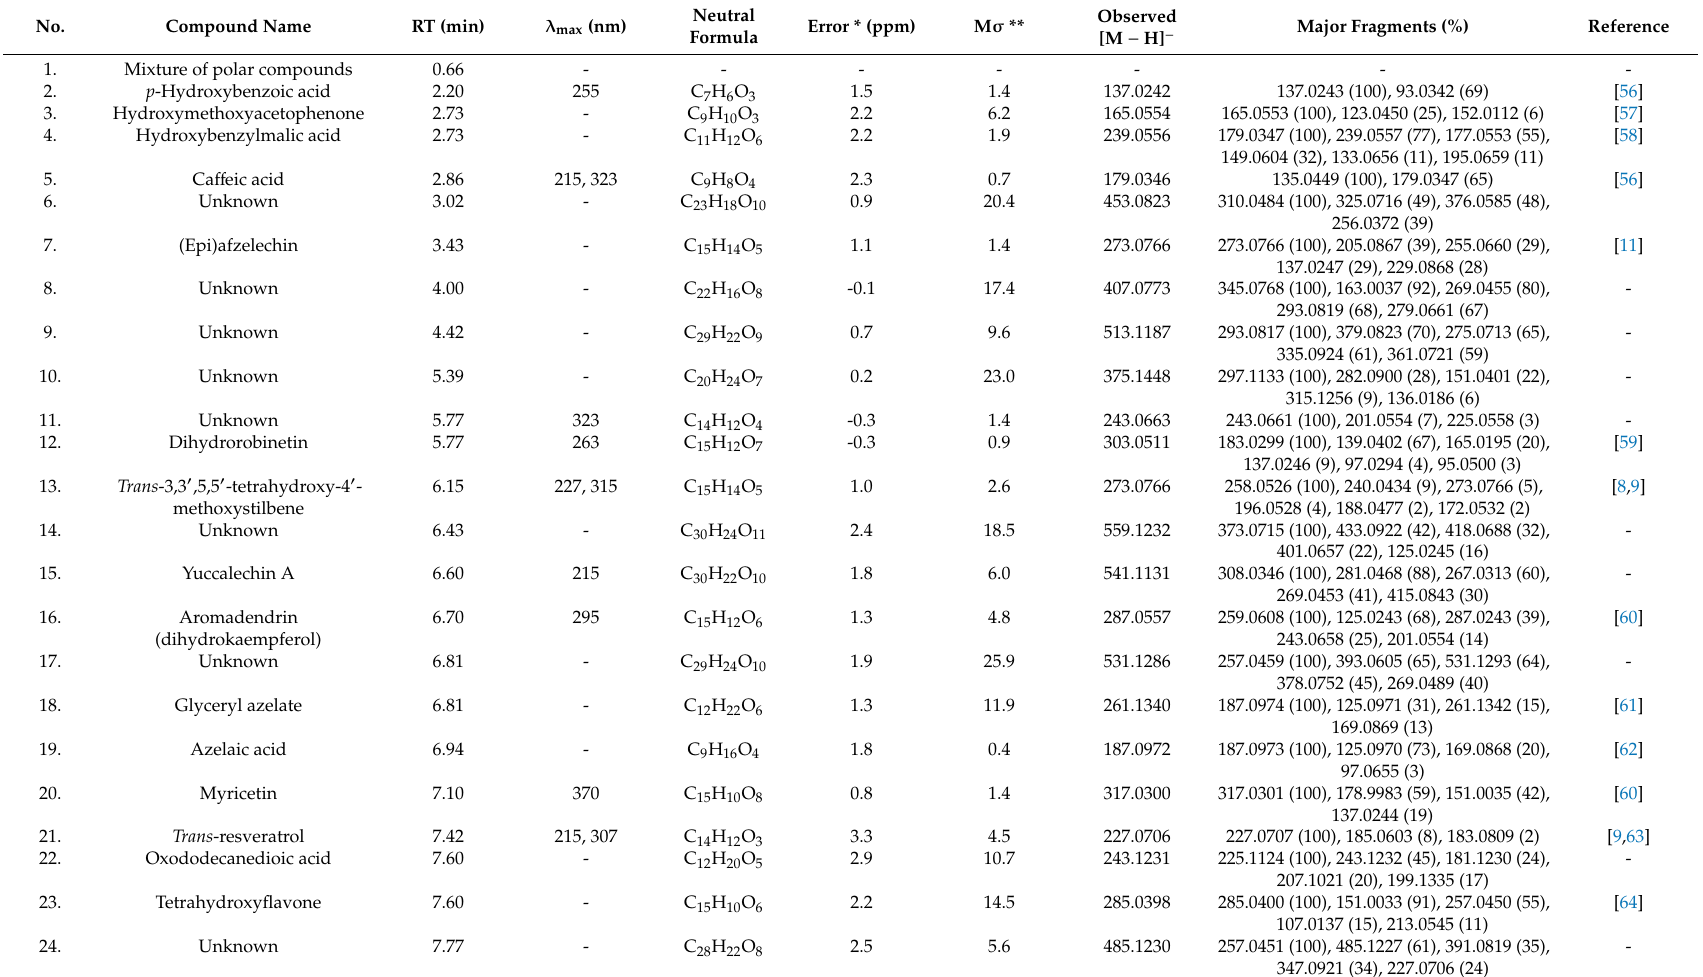
Table 1. Compounds identified in the Y. schidigera ethyl acetate fraction using ultra-high-performance liquid chromatography–quadrupole time-of-flight–tandem mass spectrometry (UHPLC-QTOF-MS /